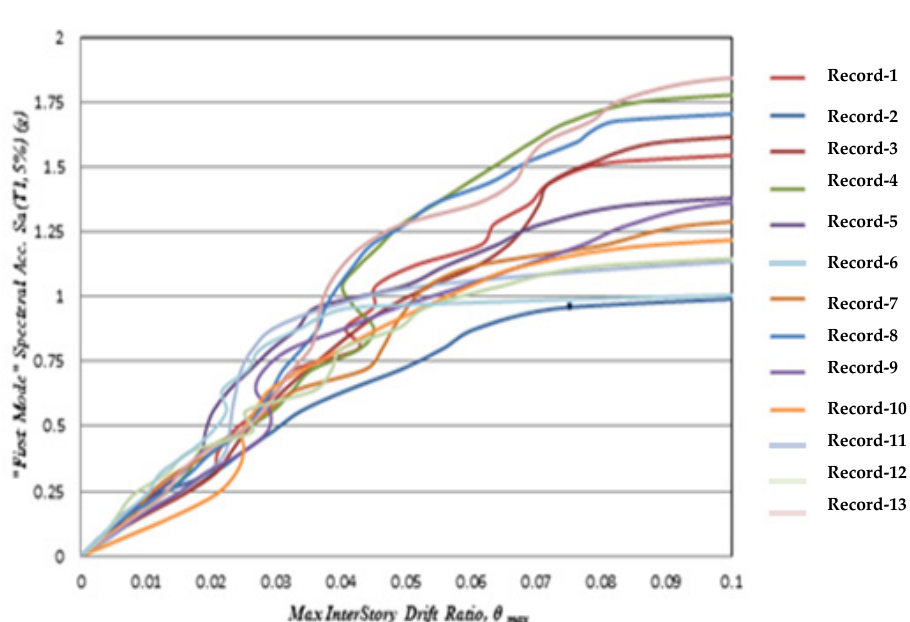
Figure 15. IDA curves obtained for a 15-story building with simple connections.